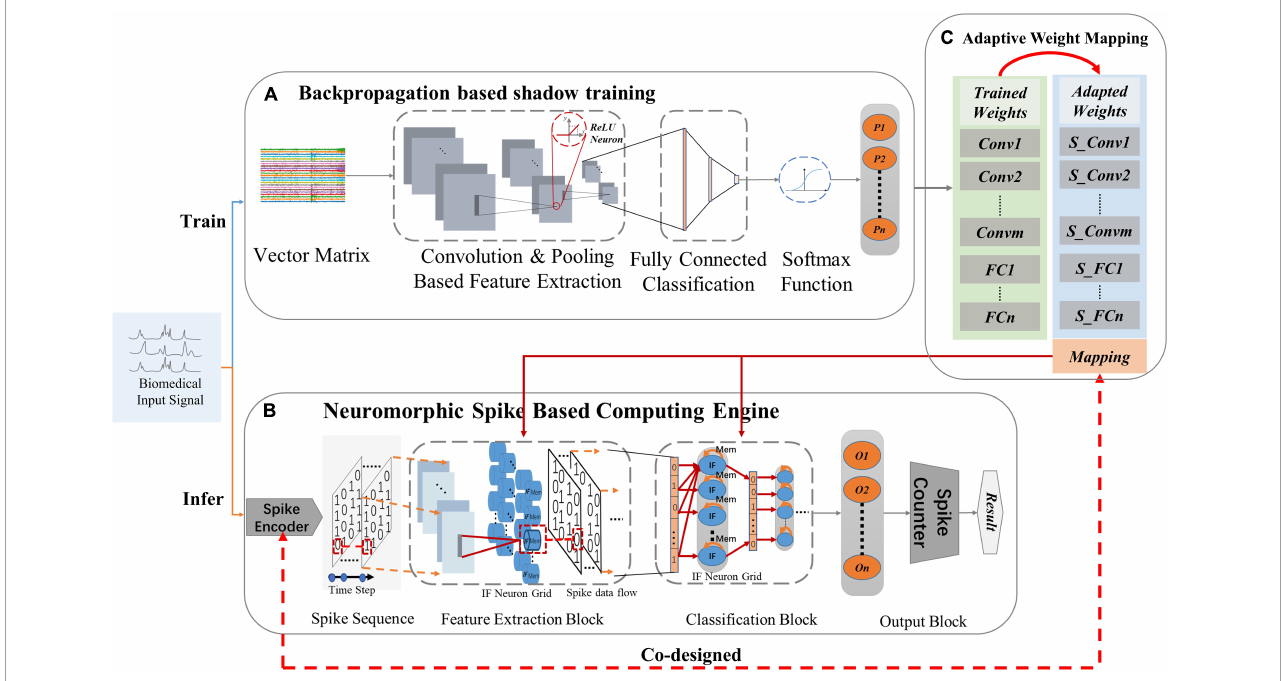
FIGURE2 Processing strategies of the proposed NeuroCARE: (A) convolutional neural network (CNN) based processing for training, where “ReLU” stands for rectified linear activation function and “P” stands for the probability of one output result, (B) Neuromorphic spike-based computing engine for inferring, where “IF” stands for “integrate and fire”, “O” stands for “output neuron” and “n” stands for the number of output neurons, (C) Weight mapping, where “Conv” stands for “convolution layer”, “S_Conv” stands for “spiking convolution layer”, “m” stands for the number of “Conv”, “FC” stands for “fully connected layer” and “n” stands for the number of